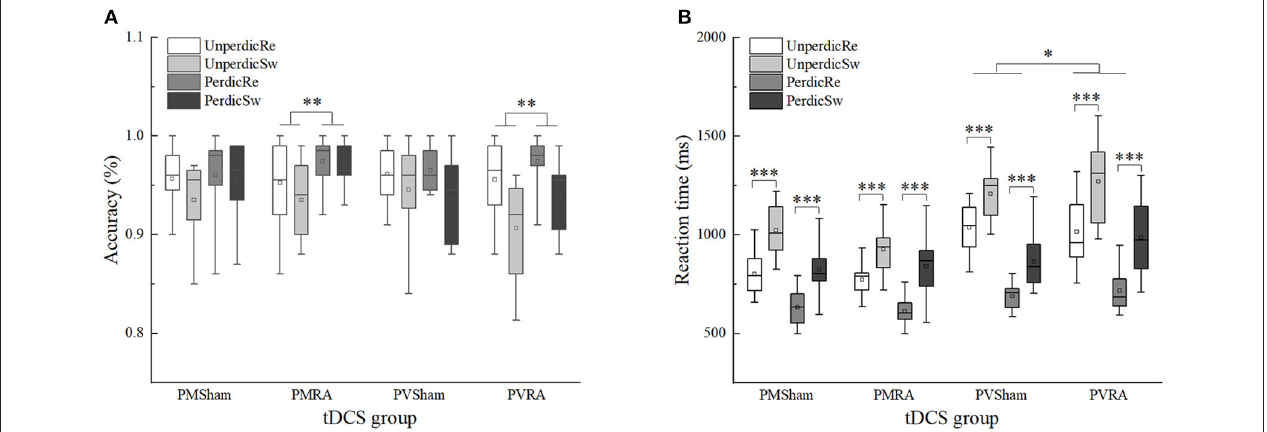
FIGURE 4 | Effects of tDCS in accuracy and reaction time between switch and repeat trials in different task types and task predictability. (A) Effects of tDCS in accuracy between switch and repeat trials. (B) Effects of tDCS in reaction time between switch and repeat trials. UnperdicRe, repeat trials in unpredictable tasks; UnperdicSw, switch trials in unpredictable tasks; PerdicRe, repeat trials in predictable tasks; PerdicSw, switch trials in predictable tasks; PMSham, parity/magnitude task in sham tDCS group; PMRA, parity/magnitude task in RA tDCS group; PVSham, parity/vowel-consonant task in sham tDCS group; PVRA,